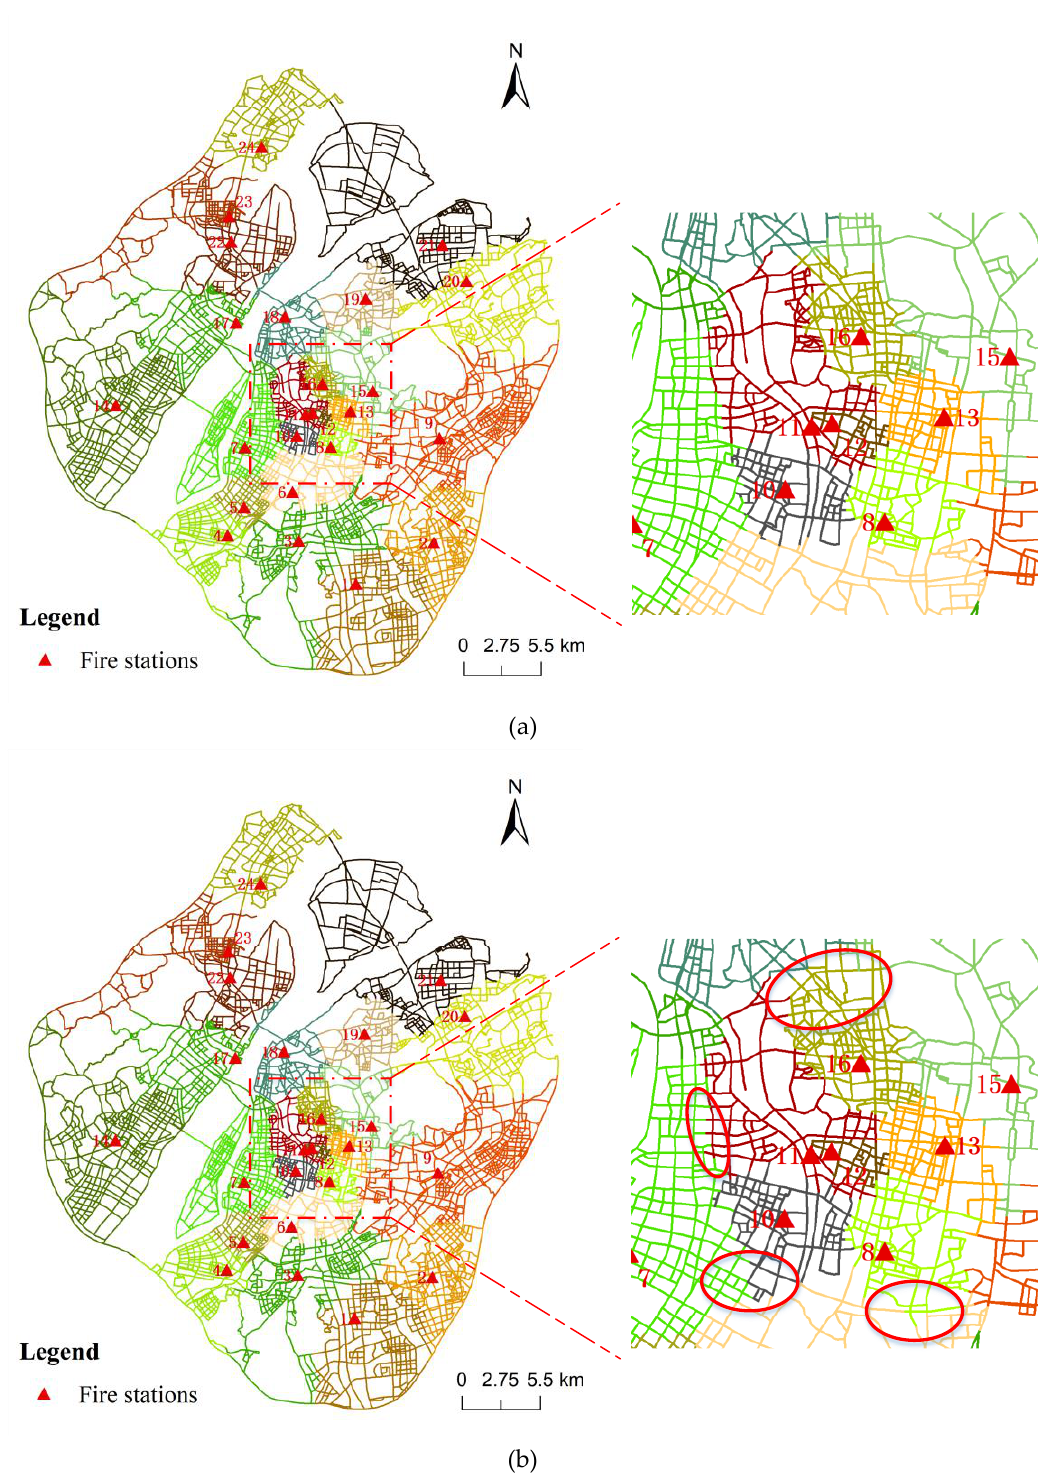
Figure 8. The results of service area delimitation of fire stations using the constrained Voronoi diagram: ( a ) the service area division without Golden 5 min constraint and ( b ) the service area division with Golden 5 min constraint.